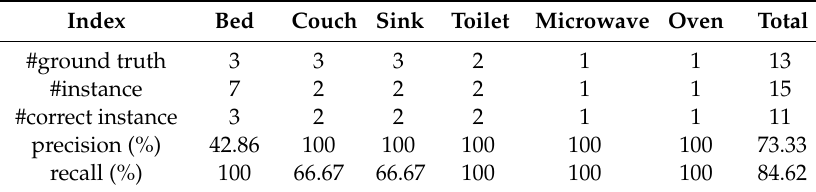
Figure 16. The results of the pare scene: ( a ) original point cloud, ( b ) point cloud with bounding rectangles, ( c ) the ground truth, and ( d ) the object semantic grid map. Table 3. The statistical results of the pare scene.